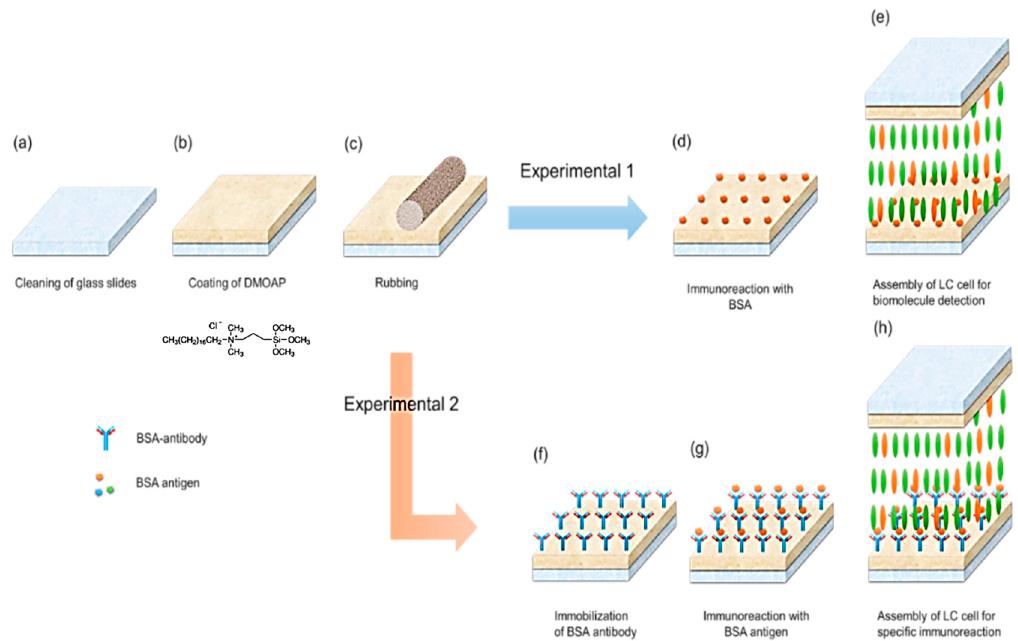
Figure 2. Schematic of the sample preparation: Experiment 1: ( a ) cleaning the substrates, ( b ) preparing alignment layer DMOAP-coated substrates, ( c ) rubbing the DMOAP-coated substrates unidirectionally, ( d ) dispensing bovine serum albumin (BSA) on one of the substrates, and ( e ) bestowing the spacer on individual parts near the substrate’s long edges, followed by self-assembling two coated substrates to form an empty device and introducing DDLC to the cell. Experiment 2: ( f ) dispensing the BSA antibody on one of the substrates, ( g ) dispensing the BSA antigen on the substrate with the BSA antibody, ( h ) self-assembling the two coated-substrates to form a sandwiched empty device, and introducing DDLCs into the device.